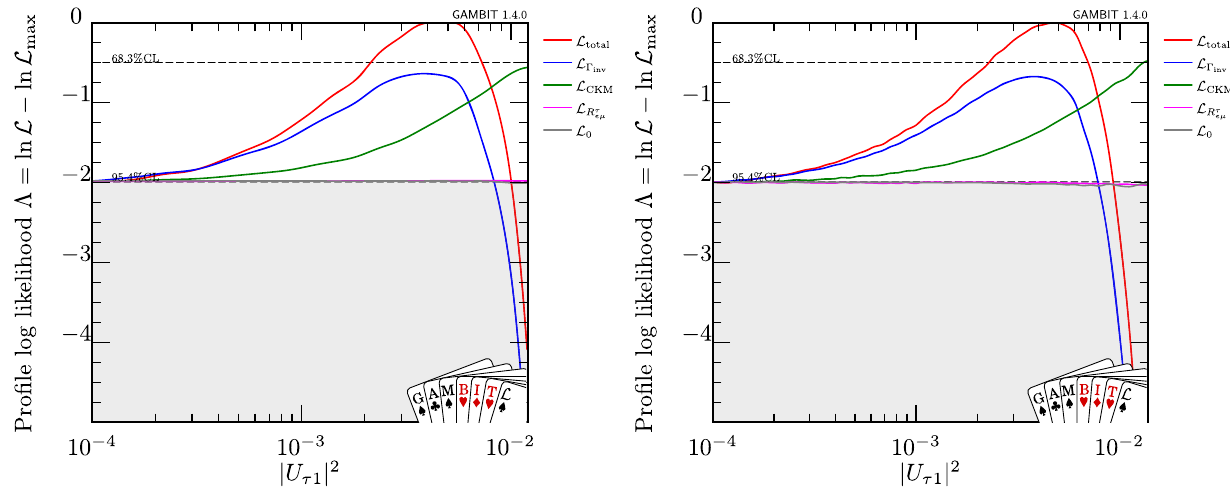
Fig. 16 One-dimensional profile likelihood for U 2 τ , L total , and partial likelihoods for Γ Z , CKM , R τ and combination of the rest of constraints, 1 > 60 GeV, for normal (left) and inverted hierarchy (right) L 0 , in the high mass region, M 1